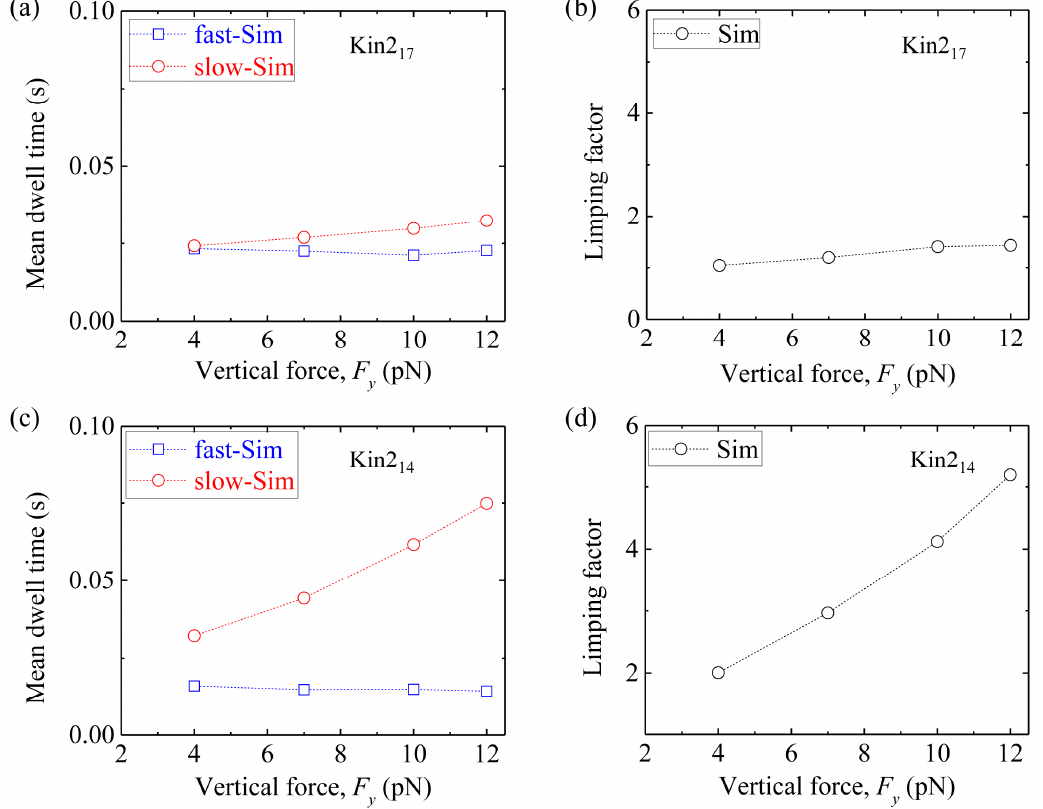
Figure 10. Limping effect of homodimeric kinesin-2 KIF3A/A with and without shortening of NLs. F x = − 5.7 pN and δ = 0.4 nm in the simulation. ( a ) The mean dwell time of the odd (red circles) and even stepping phases (blue squares) versus F y for Kin2 17 . ( b ) Limping factor versus F y for Kin2 17 . ( c ) The mean dwell time of the odd (red circles) and even stepping phases (blue squares) versus F y for Kin2 14 . ( d ) Limping factor versus F y for Kin2 14 .